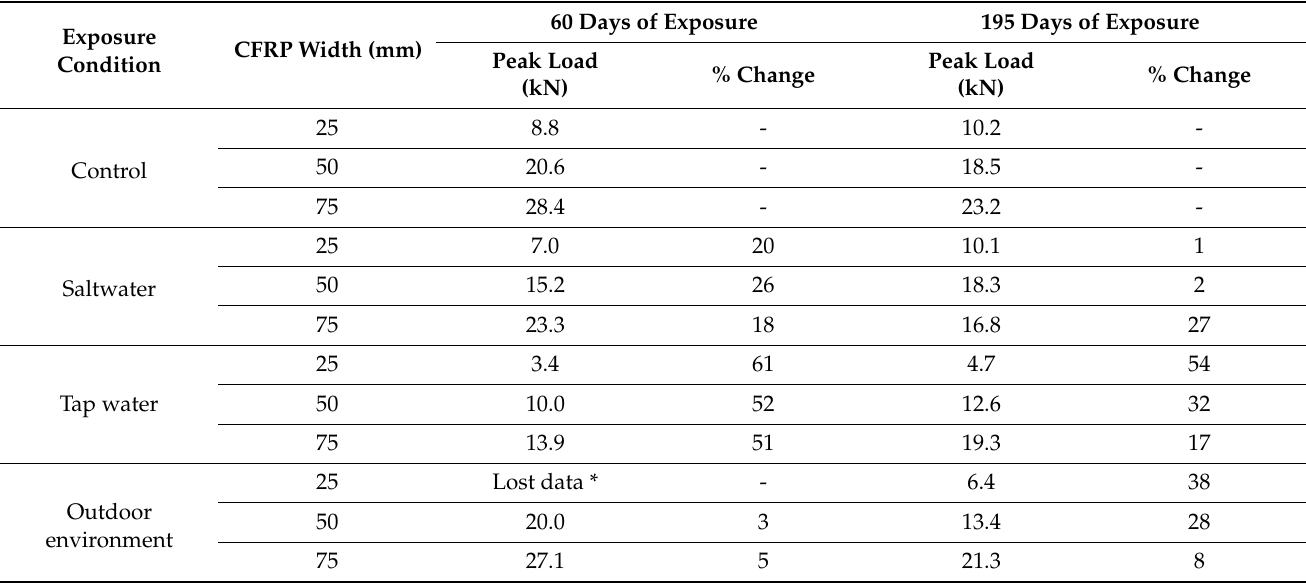
Figure 9. Effect of 60 days of exposure on the CFRP strength. Table 5. Peak loads from the pull-off shearing tests after 60 and 195 days of exposure.